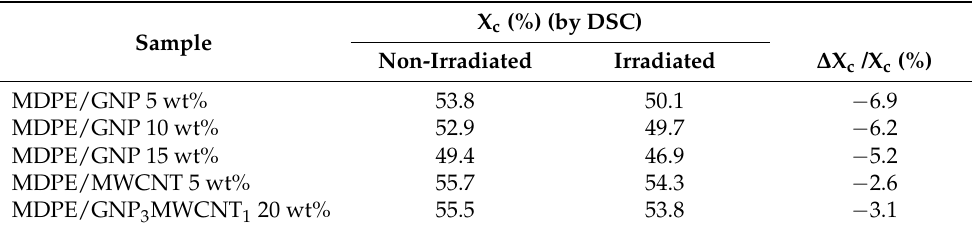
Table 5. Degree of crystallinity (X c ) and relative percentage variation ( ∆ X c /X c ) calculated by DSC of MDPE/GNP and MDPE/MWCNT nanocomposites at different filler concentrations